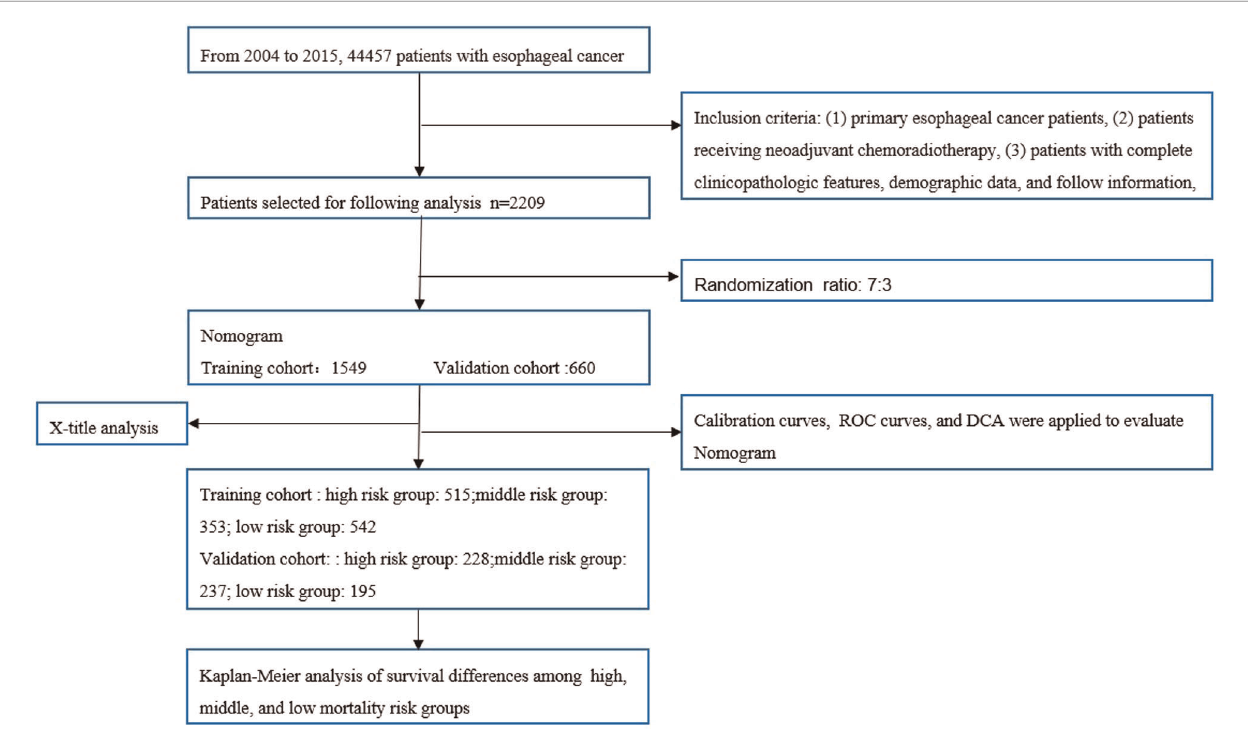
FIGURE 1 | Flowchart of patient selection and analysis procedures. ROC, receiver operating characteristic; DCA, decision curve